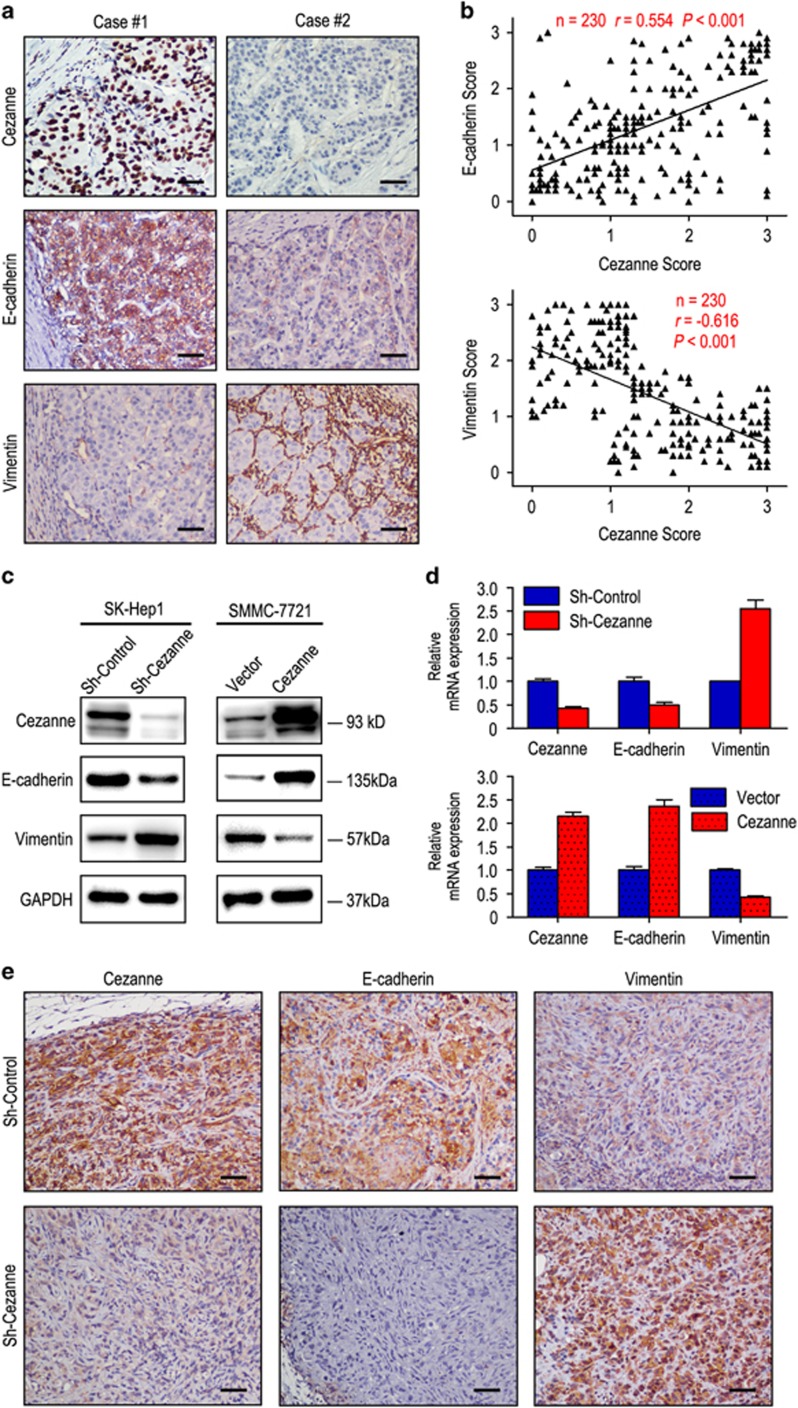
Cezanne expression level correlated with the expression of epithelial–mesenchymal transition (EMT) markers. (a) Serial sections of human HCC tissues were subjected to IHC staining with antibodies against Cezanne, E-cadherin and vimentin. In case 1, high expression of Cezanne in HCC tissues was accompanied by elevated E-cadherin and the absence of vimentin. In case 2, low expression of Cezanne was accompanied by the absence of E-cadherin and elevated vimentin. The scale bar represents 50 μm. (b) Cezanne expression was positively correlated with E-cadherin expression and negatively associated with vimentin expression. (c and d) Transfecting siRNAs against Cezanne decreased Cezanne expression, downregulated E-cadherin and upregulated vimentin. Overexpression of Cezanne upregulated E-cadherin and downregulated vimentin. (e) Representative images of IHC staining of mice xenografts of SK-Hep1 sh-Cezanne and control cells. The scale bar represents 50 μm